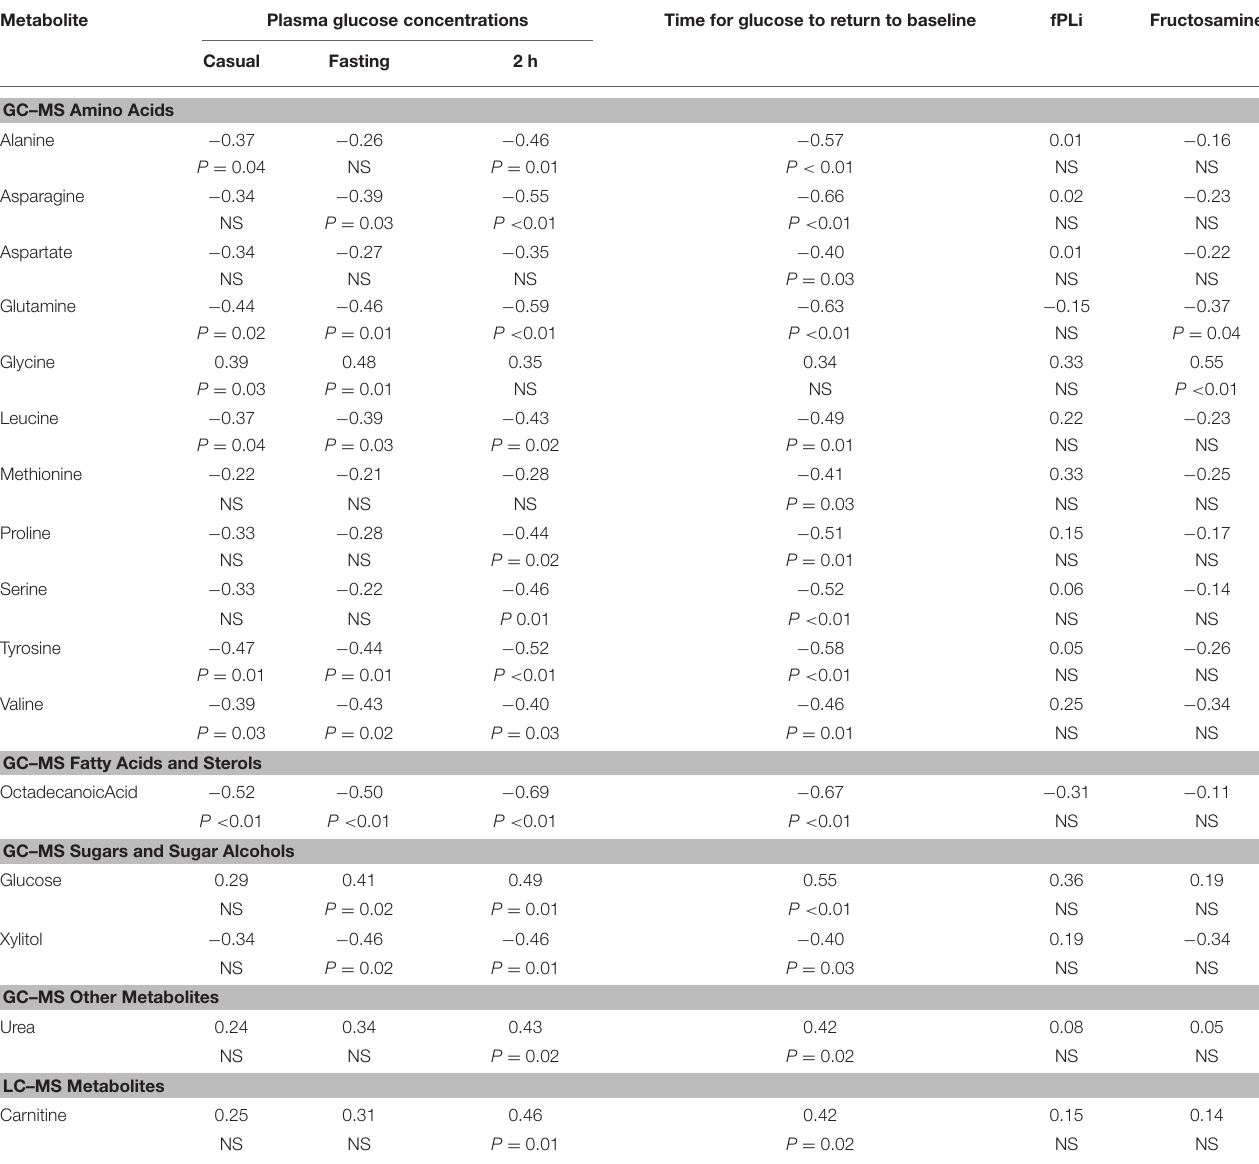
TABLE 3 | Correlation coefficients (and p -values for testing null hypotheses that the correlation is 0) for correlations between selected metabolites and each of casual, fasting, and 2h glucose, time for glucose to return to baseline, fPli and fructosamine. Metabolite Plasma glucose concentrations Time for glucose to return to baseline fPLi Fructosamine Casual